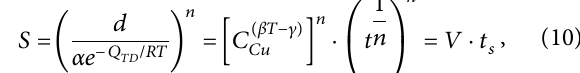
� 0.57, T � 125 ° C; (c) C cu